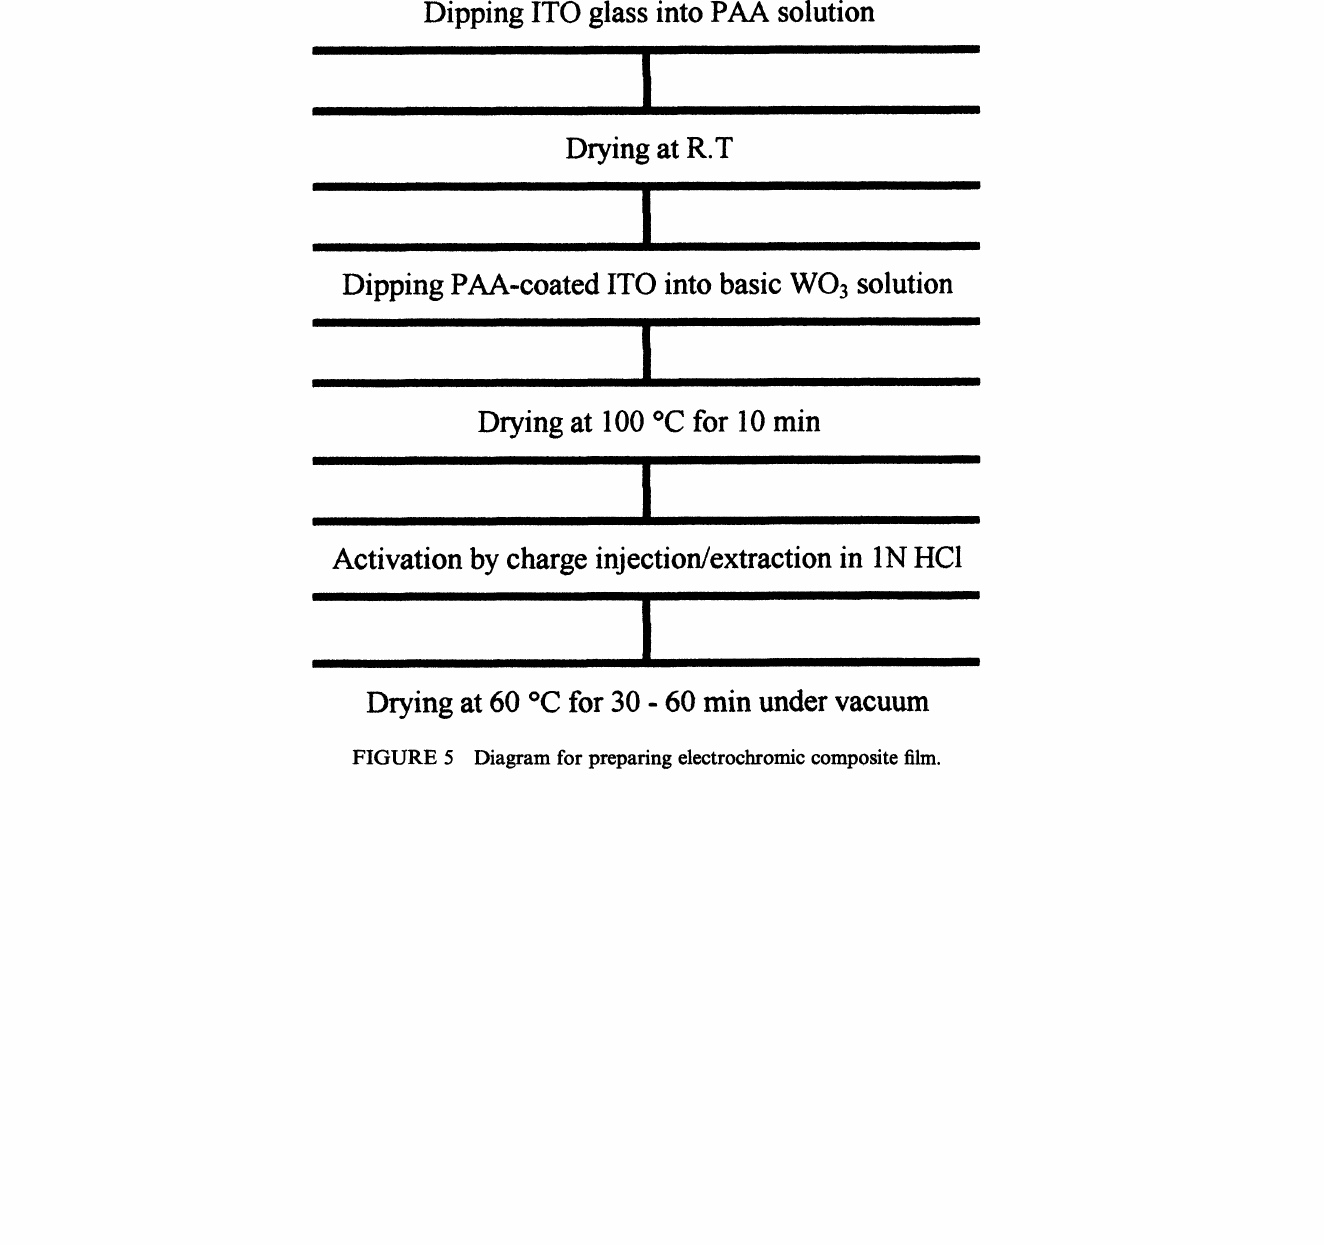
FIGURE 5 Diagram for preparing electrochromic composite